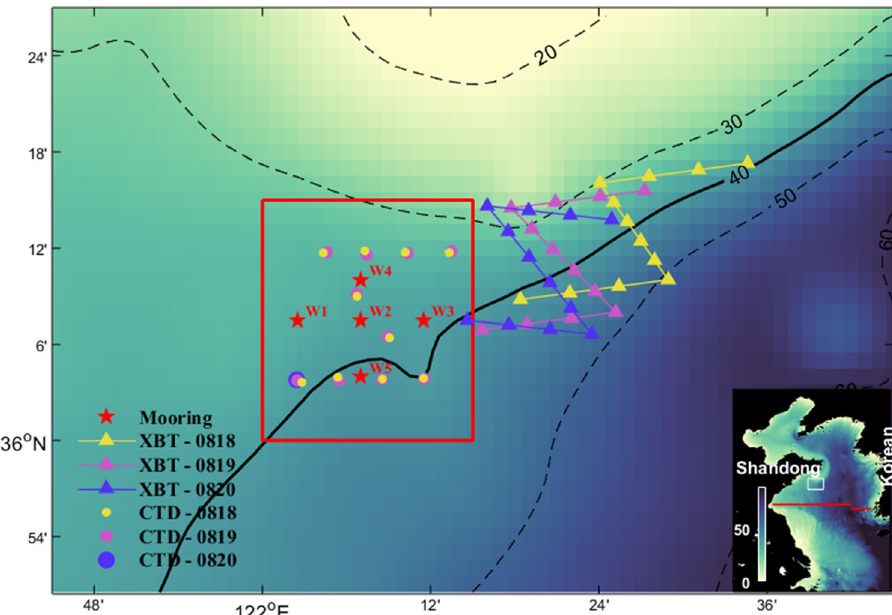
Figure 1. Plan view of the locations of the five temperature profile buoy stations (red stars), thirty-six XBT stations (triangles), and twenty-one shipboard CTD stations (circles). The differences in the deployment times of the XBT and shipboard CTD observations are distinguished by different colors. The red box indicates the location of the target region. The topography is indicated by shading. The bottom-right insert shows the model area, in which the write box indicates the position of the study area and the red lines indicate the section locations used for vertical thermal structure validation. Figures are plotted using MATLAB R2017a (http:// www. mathw orks. com/) with M_Map v1.4 (a mapping package, http:// www. eos. ubc. ca/ ~rich/ map.